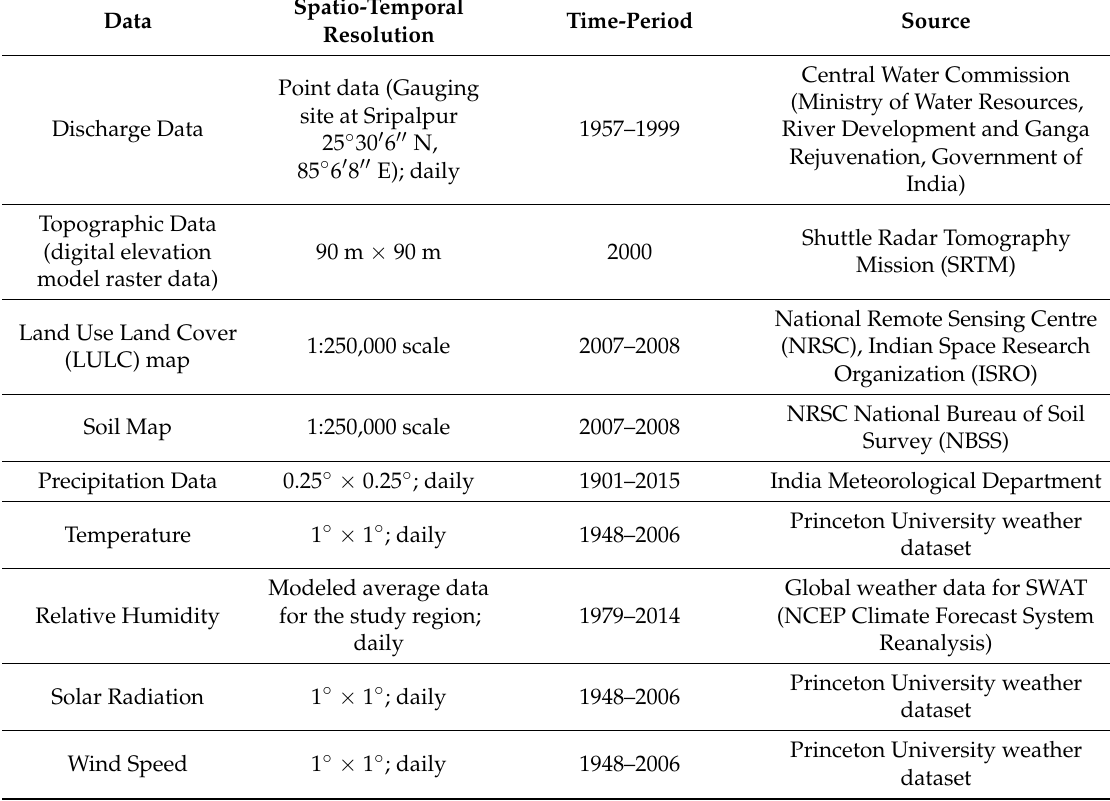
Table 1. Datasets used for the model